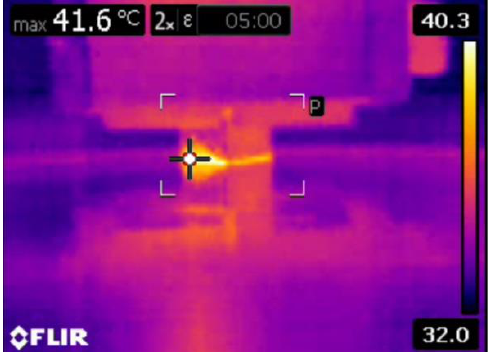
Figure 16. Temperature of the hybrid composite pin at 50 N loads at 5 min.